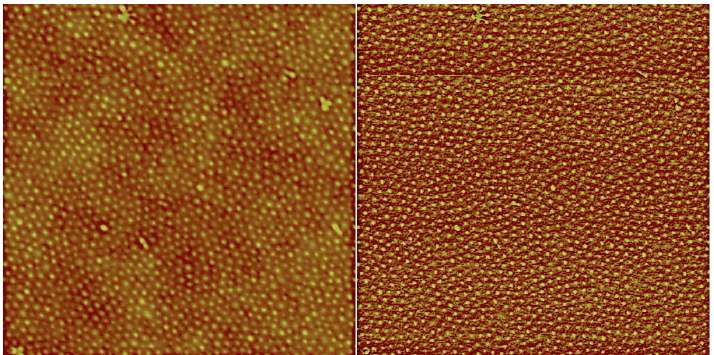
Figure 3 . AFM images (left: height image, right: phase image) of a PS- b -P4VP thin film spin-coated on a silicon substrate from a 2 wt % solution in 1,4-dioxane (images are 2 × 2 μ m 2